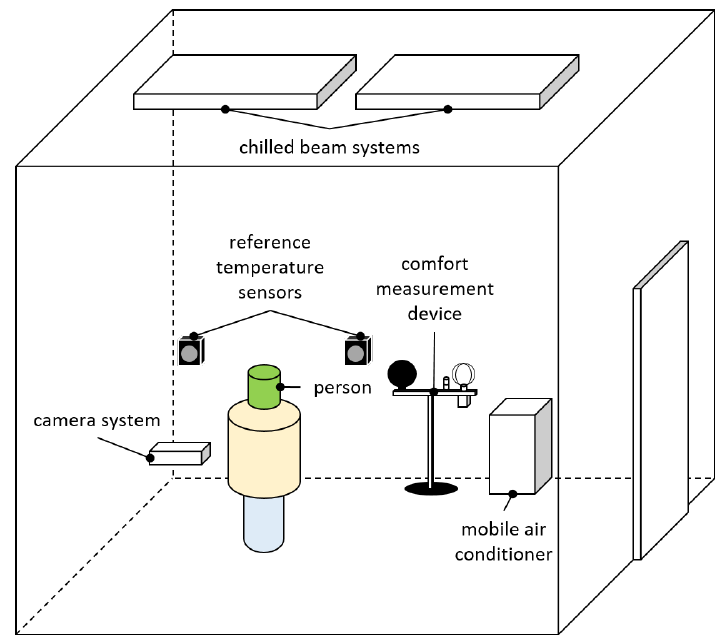
Figure 3. Schematic of the experimental setup